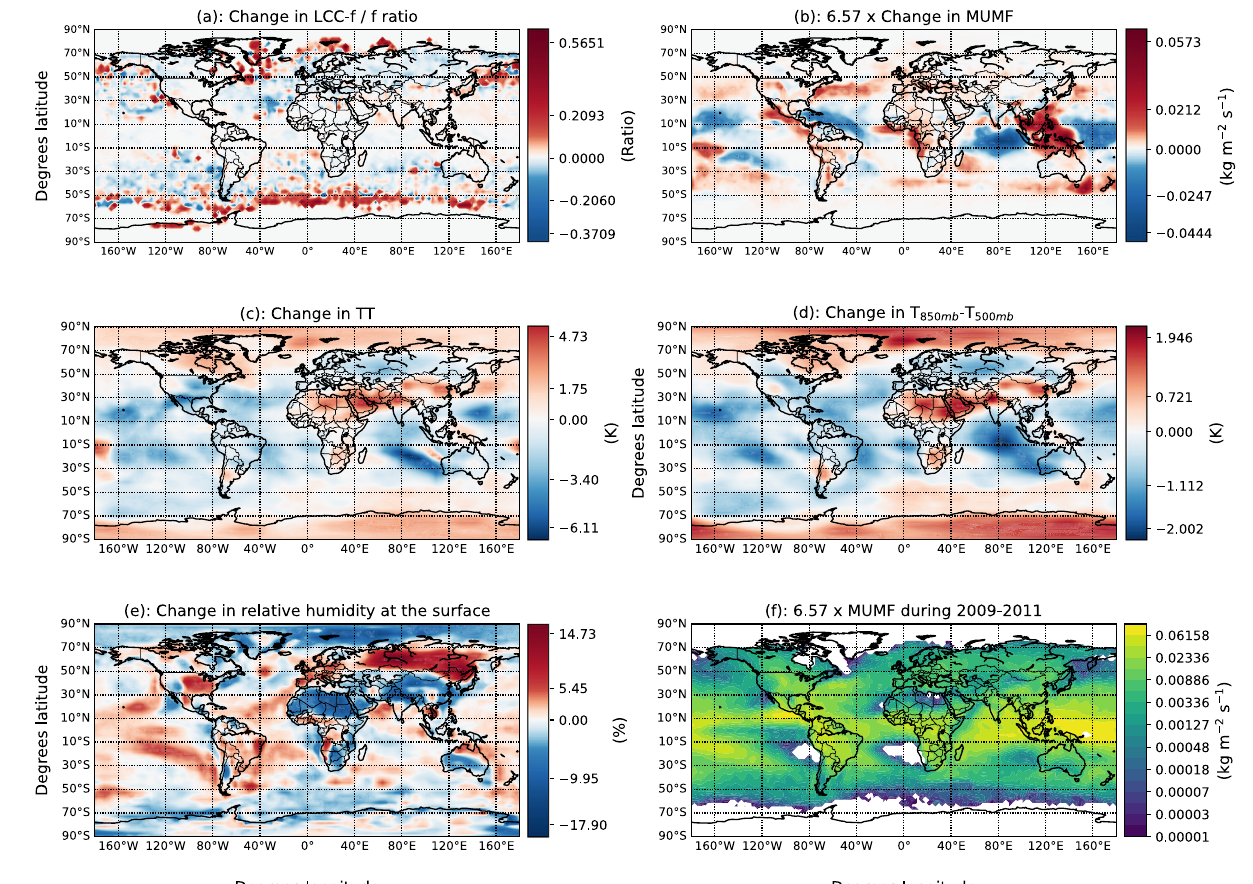
Fig. 2 | Annually averaged changes of the ratio of meteorological parameters thatarerelevantforlightningandLong-Continuing-Current(LCC). Theplotted parameters are the ratio of LCC to total lightning ( a ), the mean updraft mass fl ux (MUMF) at 440 hPa pressurelevel in thunderstorms ( b ), the total totals (TT) index ( c ),thetemperaturedifferencebetweenthe850mbandthe500mbpressurelevels ( d ), and the change in relative humidity at the surface ( e ) between the periods 2009 – 2011and2091 – 2095. f AnnuallyaveragedMUMFat440hPapressurelevelin